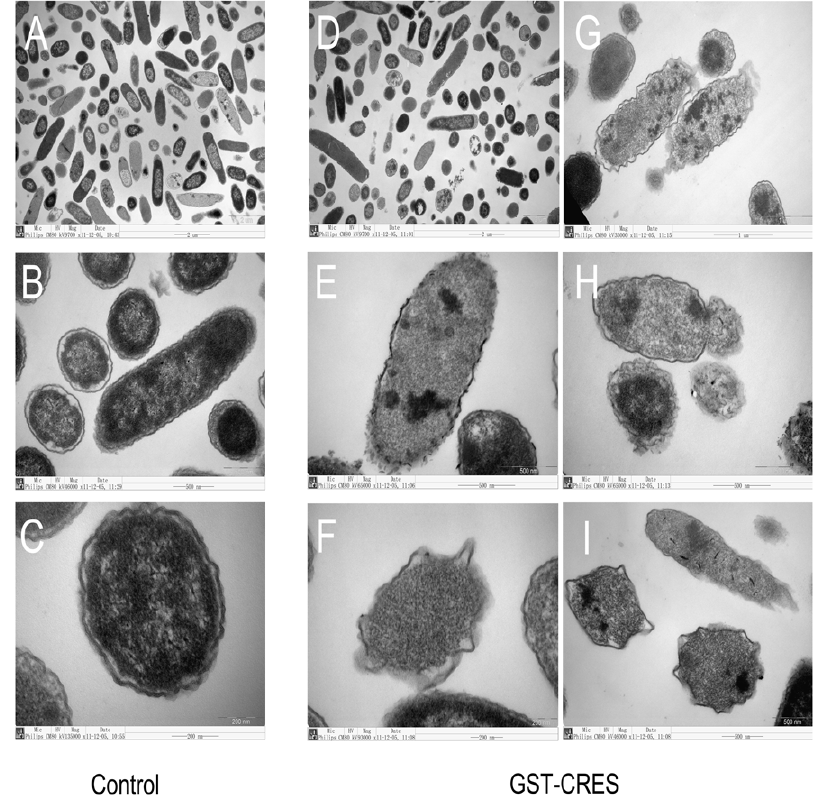
Figure 6. Transmission electron micrographs of E.coli D5 a . (A–C) E. coli D5 a incubated with buffer. (D–I) E. coli D5 a incubated with GST-CRES.